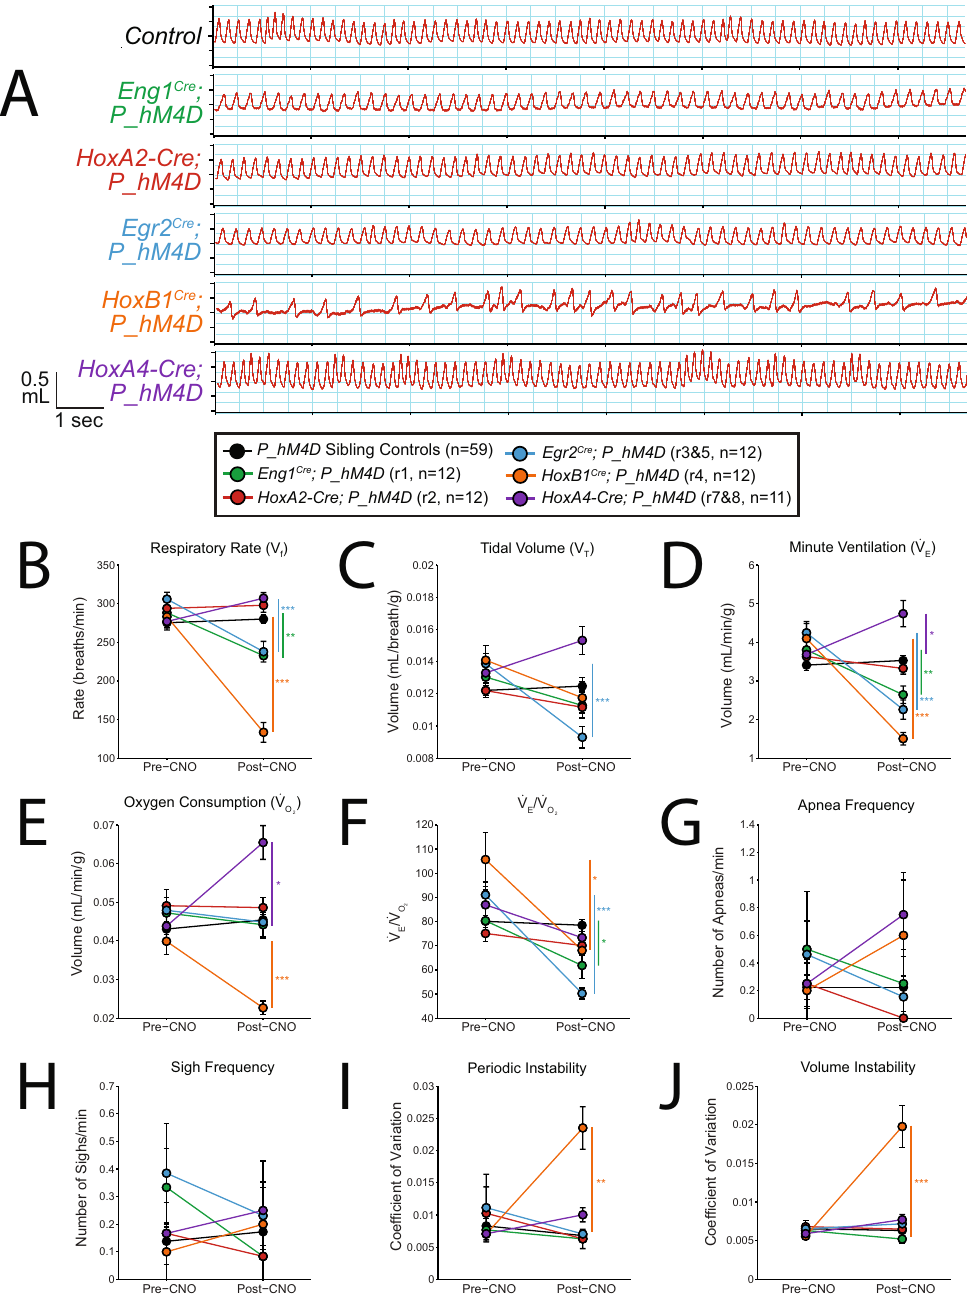
Figure 4. CNO-hM4D perturbation of rhombomeric domains in the adult animal results in a variety of respiratory phenotypes under hypercapnic (5% CO 2 ) conditions. ( A ) Representative traces of respiratory wavesforms in P_hM4D sibling controls and rhombomere-Cre; P_hM4D mice after CNO injection under hypercapnic conditions. ( B–F ) Quantification of pre- and post-CNO respiratory parameters. Perturbation of rhombomere-derived populations under room air conditions results in increases, decreases, and no change in respiratory rate ( B ), tidal volume ( C ), minute ventilation ( D ), oxygen consumption ( E ),  V frequency ( G ), sigh frequency ( H ), periodic instability ( I ), and volume instability ( J ) as compared to pre-CNO values and sibling controls. Statistical significance was determined using a linear mixed-effects regression model with animal type (experimental or control) and CNO treatment (pre or post) as fixed effects and animal ID as a random effect. * p < 0.05, ** p < 0.01, *** p <